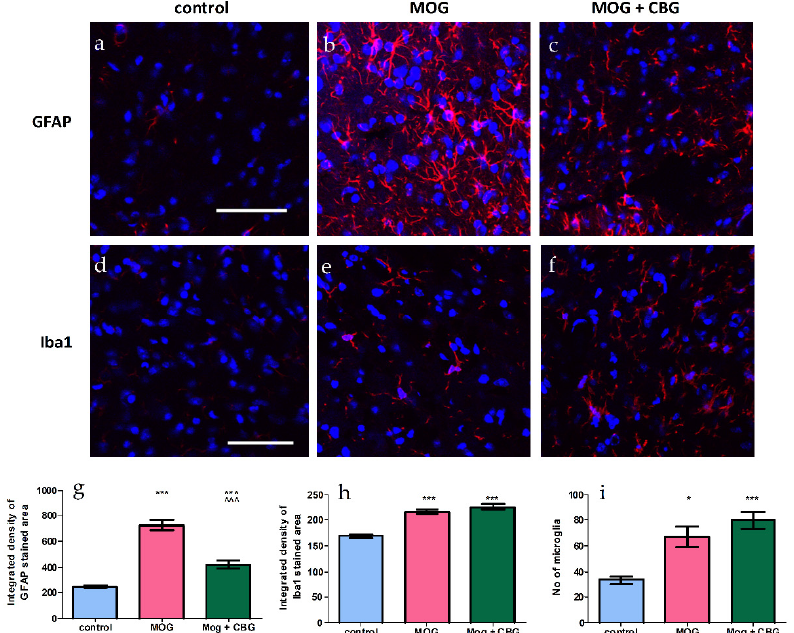
Figure 6. Immunohistochemistry of spinal cords of non-treated and EAE mice. Lumbar sections were stained with GFAP ( a – c ) and Iba1 ( d – f ) (red), and counterstained for nuclei with DAPI (blue). Representative lumbar layers from the mice groups are presented (one experiment, n = 4–6 in each group). Immunodetections were quantified and plotted as integrated density for each antibody ( g , h ). The average number of microglia are presented in ( i ). One way ANOVA followed by a Tukey–Kramer multiple comparison test were performed to determine statistical significance. * p < 0.05 vs. control, *** p <0.001 vs. control; ^^^ p <0.001 vs. MOG. The scale bar is 50 µm.